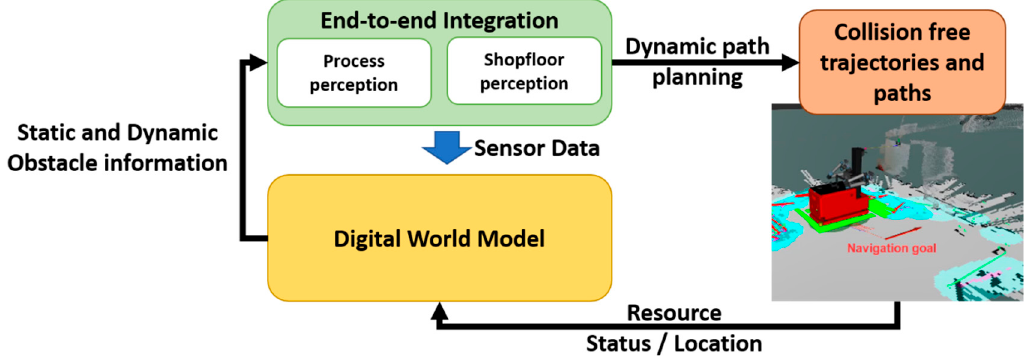
Figure 2. Robotic perception for robot behavior adaptation concept .